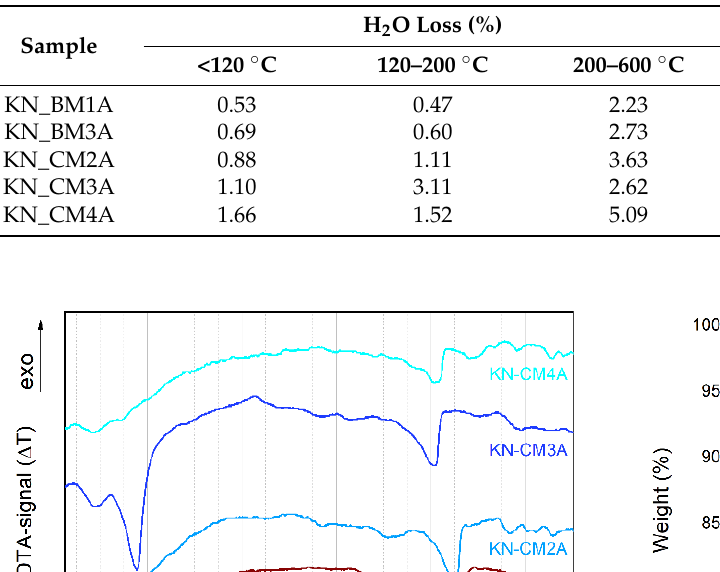
Table 5. Results obtained by TG–DTA: mass loss of water, of CO 2 and CO 2 /H 2 O ratio.